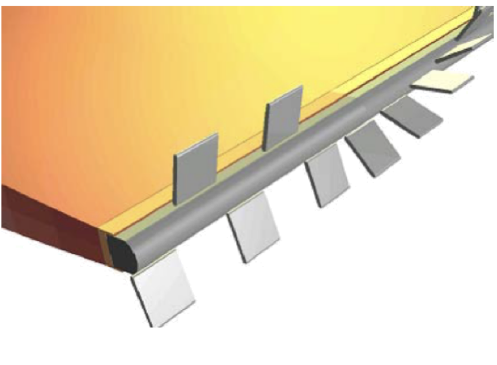
Figure 3. Array of Miniature Trailing Edge Effectors (MiTEs) (adapted from Lee and Kroo [14]).